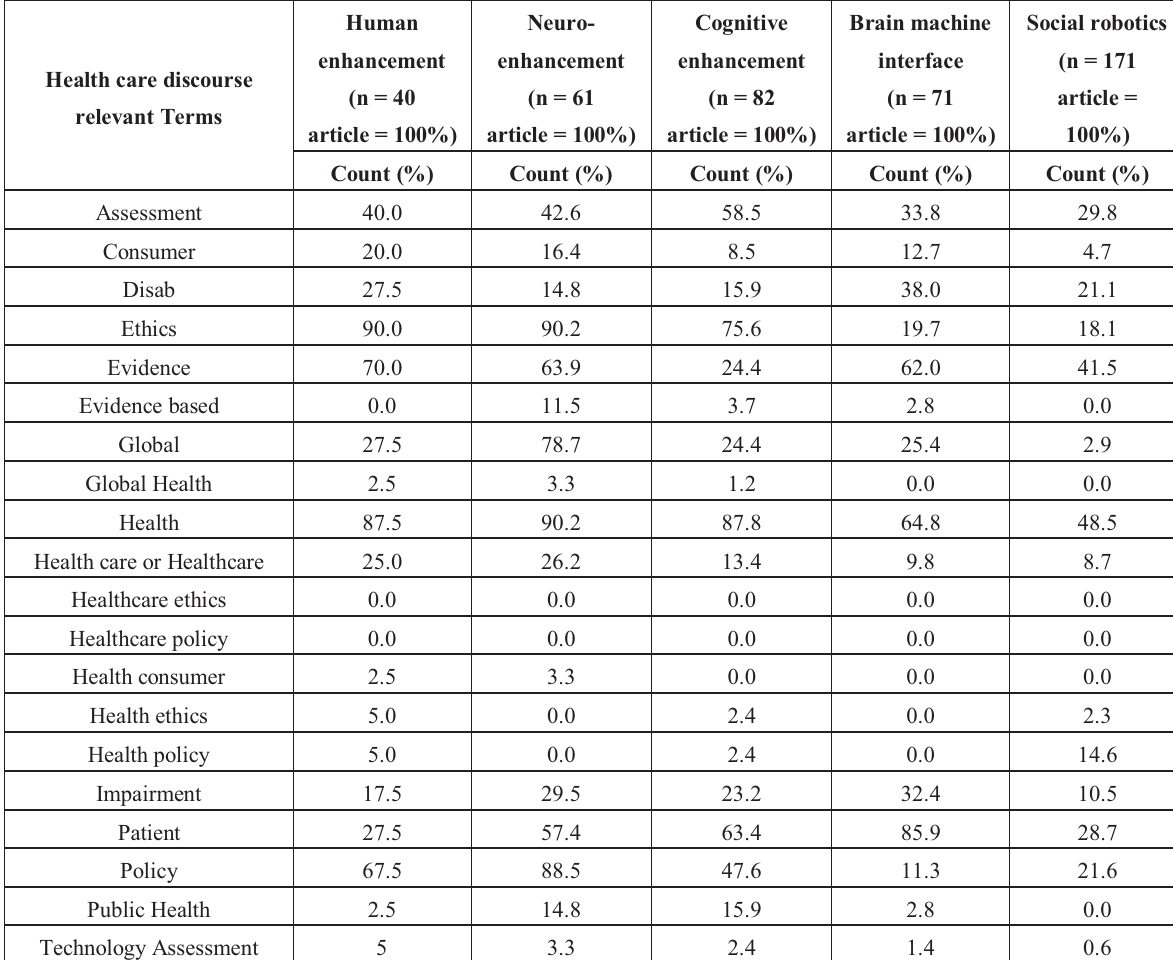
Table 1. Quantitative data of the themes covered in Section